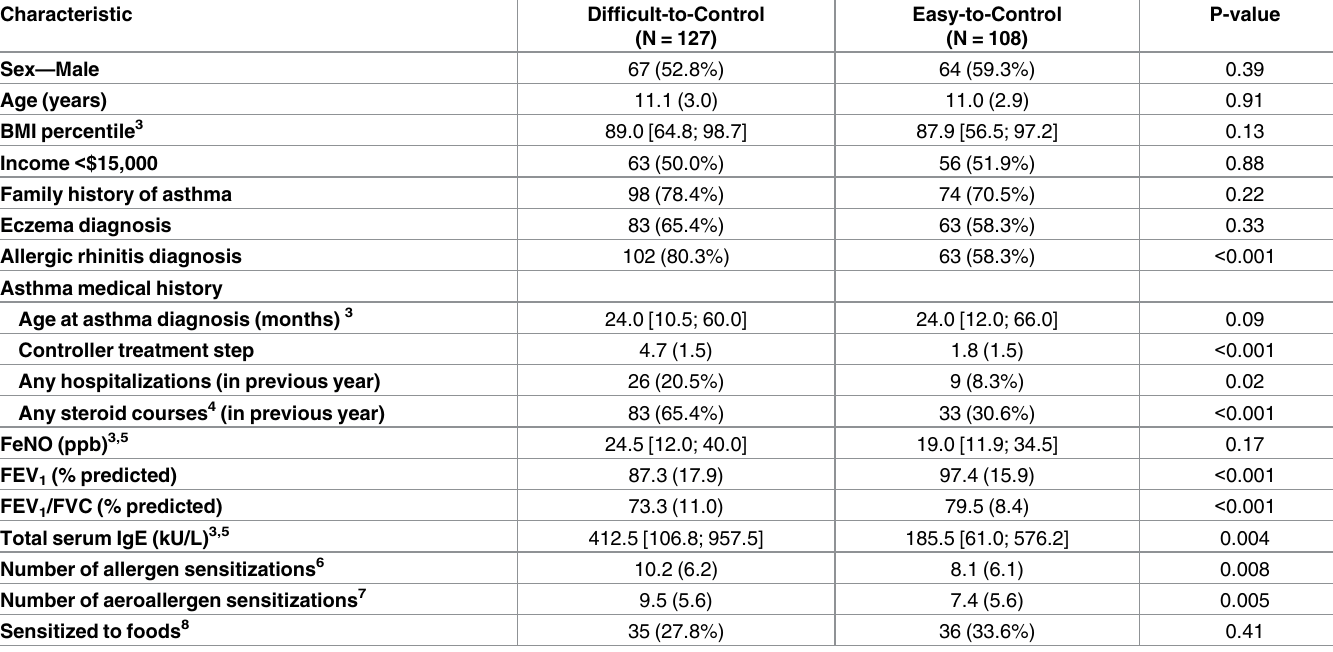
Table 1. Participant characteristics and demographics 1,2 .